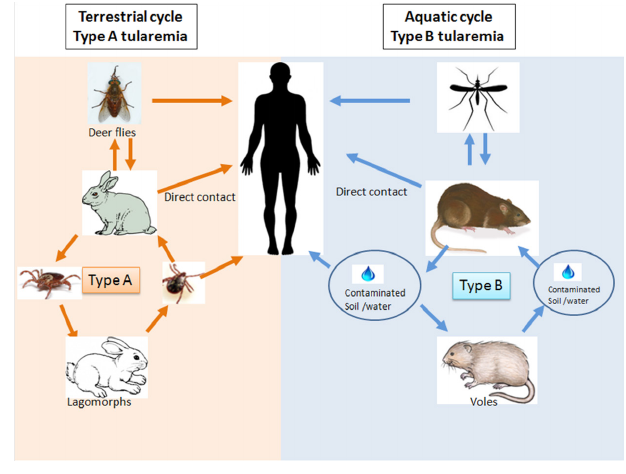
Figure 3 . Transmission of Tularemia to Human by Ticks and the Life Cycle of Francisella tularensis in Nature.